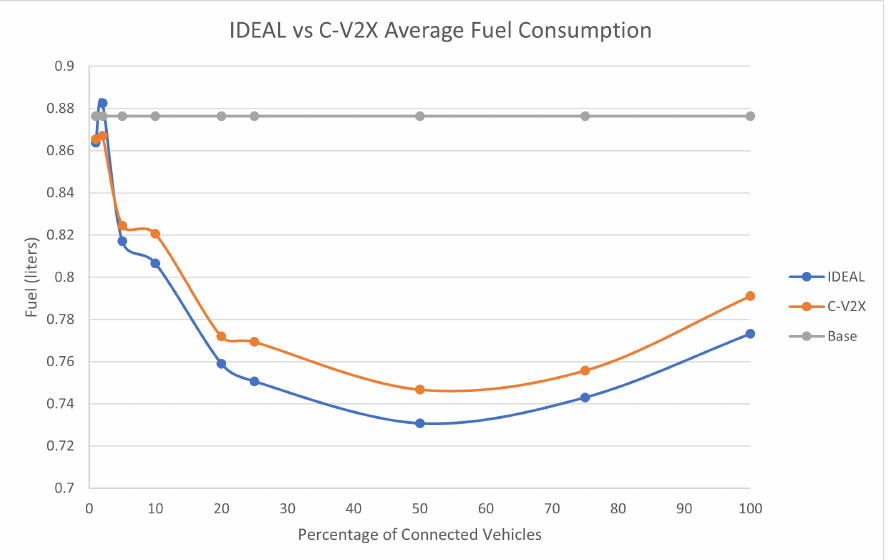
Figure 4. Average network-wide Fuel consumption of Energy-Efficient dynamic routing application using IDEAL and C-V2X communication on LA road network with traffic demand of scale factor